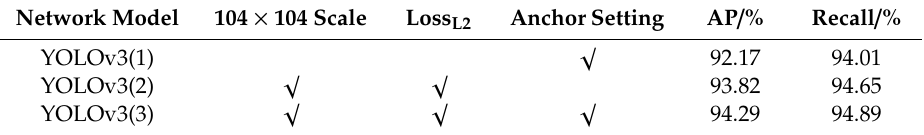
Table 5. Performance comparison of each part of the improved model on the MyPlane dataset.